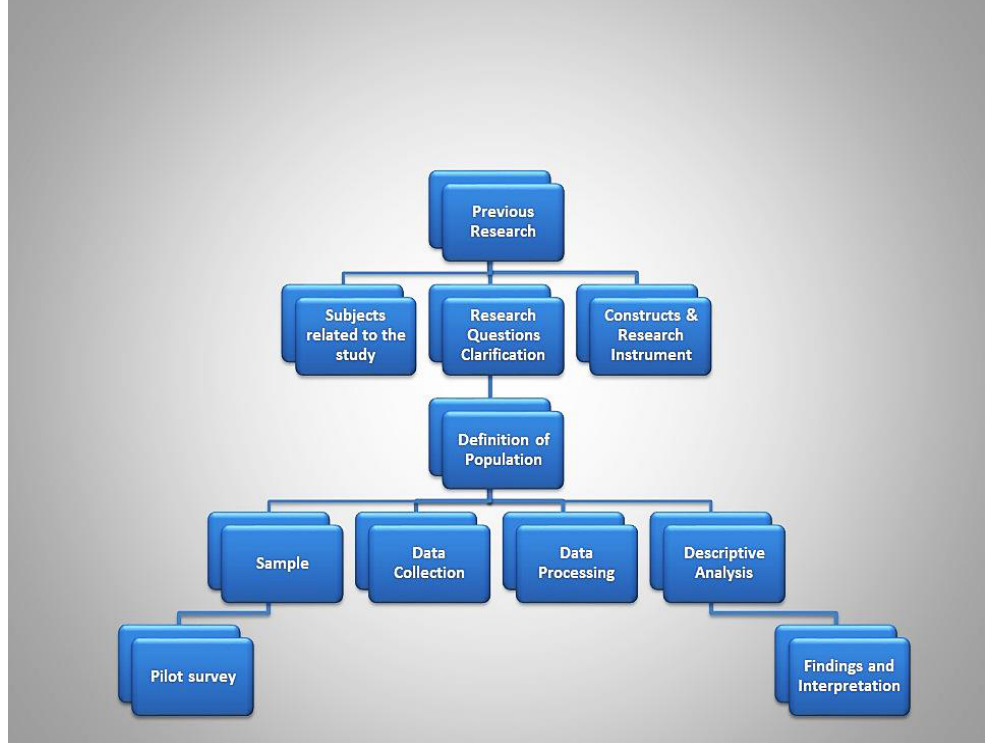
Figure 1. Research methodology flow chart for s tudents’ BS acceptance in Greek HEIs.